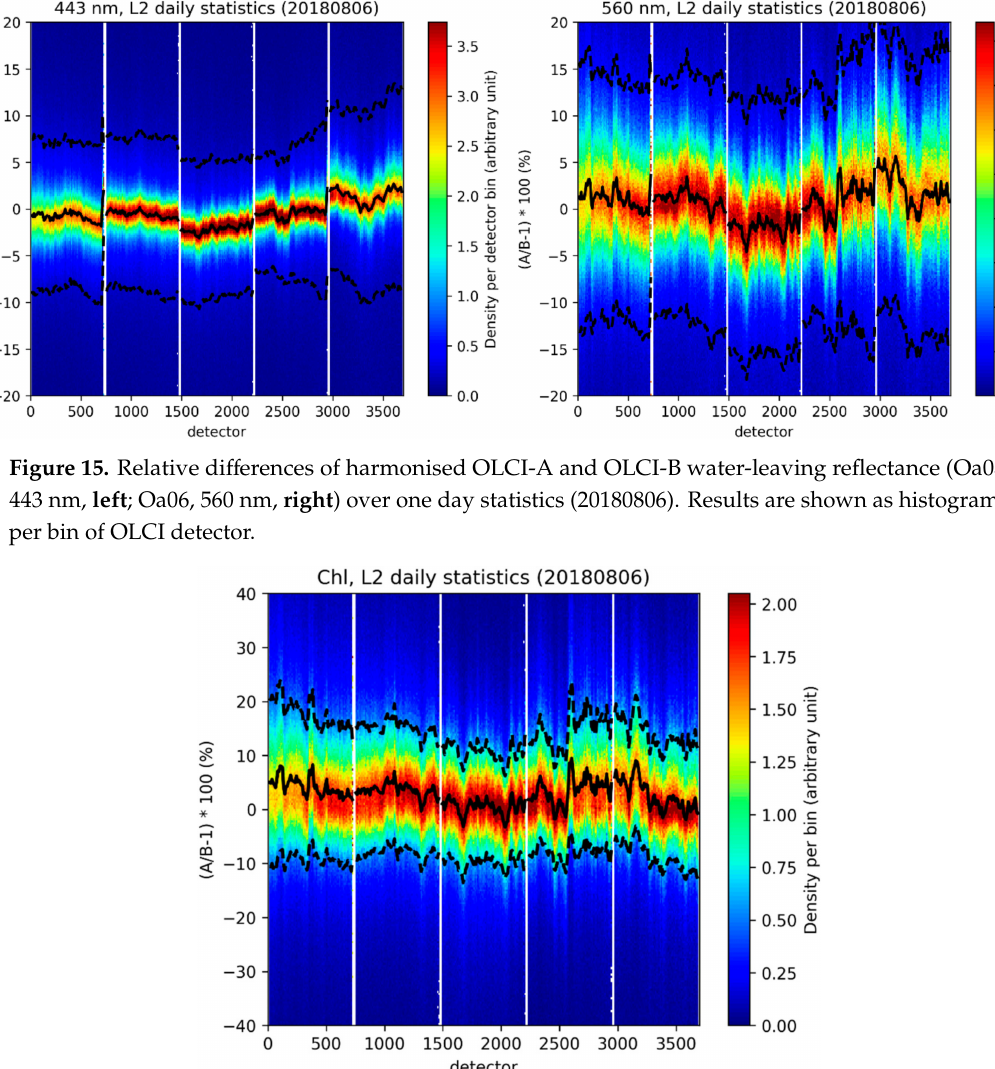
Figure 16. Relative di ff erences of harmonised OLCI-A and OLCI-B Chl (natural unit) over one day statistics (20180806). Results are shown as histograms per bin of OLCI